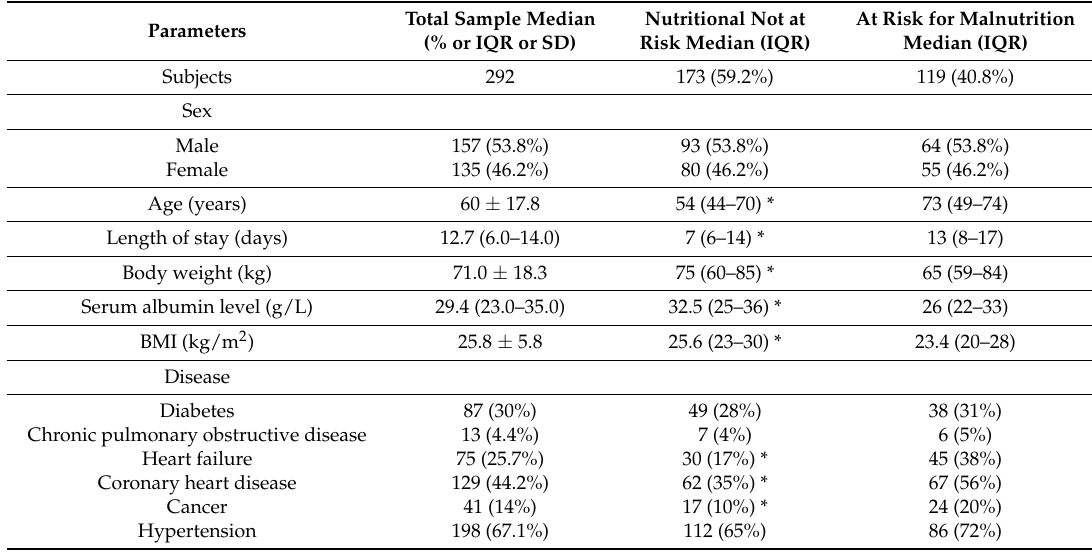
Table 1. Patient characteristics according to Nutritional Risk Screening-2002 (NRS-2002; NRS < 3 patients not at risk, NRS ≥ 3 patients at risk for malnutrition). Total Sample Median Parameters (% or IQR or